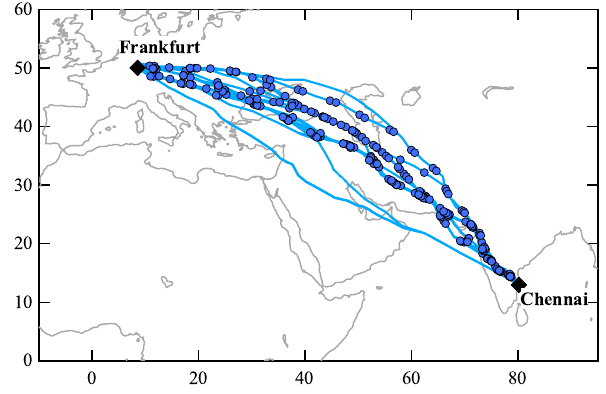
Fig. 1. CARIBIC flights between Germany and India in 2008. Shown are the flight routes for 16 round trips between Frankfurt and Chennai from April to December 2008. On 9 round trips air samples were taken at the positions